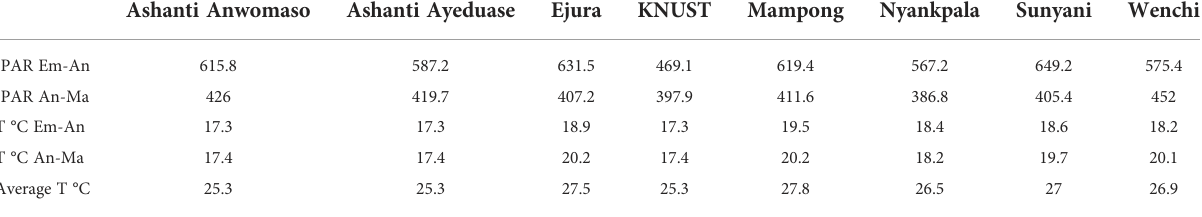
TABLE 7 Daily average intercepted photosynthetic active radiation (IPAR) and temperature (T) in the study locations. Ashanti Anwomaso Ashanti